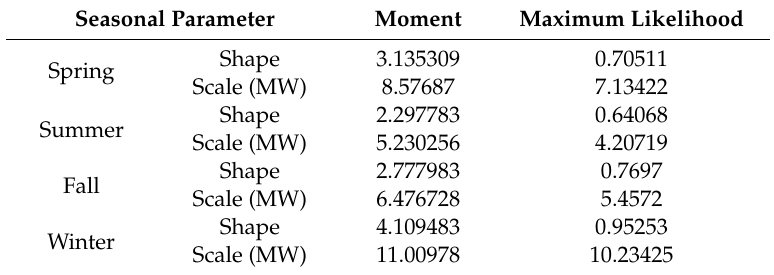
Table 1. Parameter estimation of Weibull distribution using the moment method and maximum likelihood